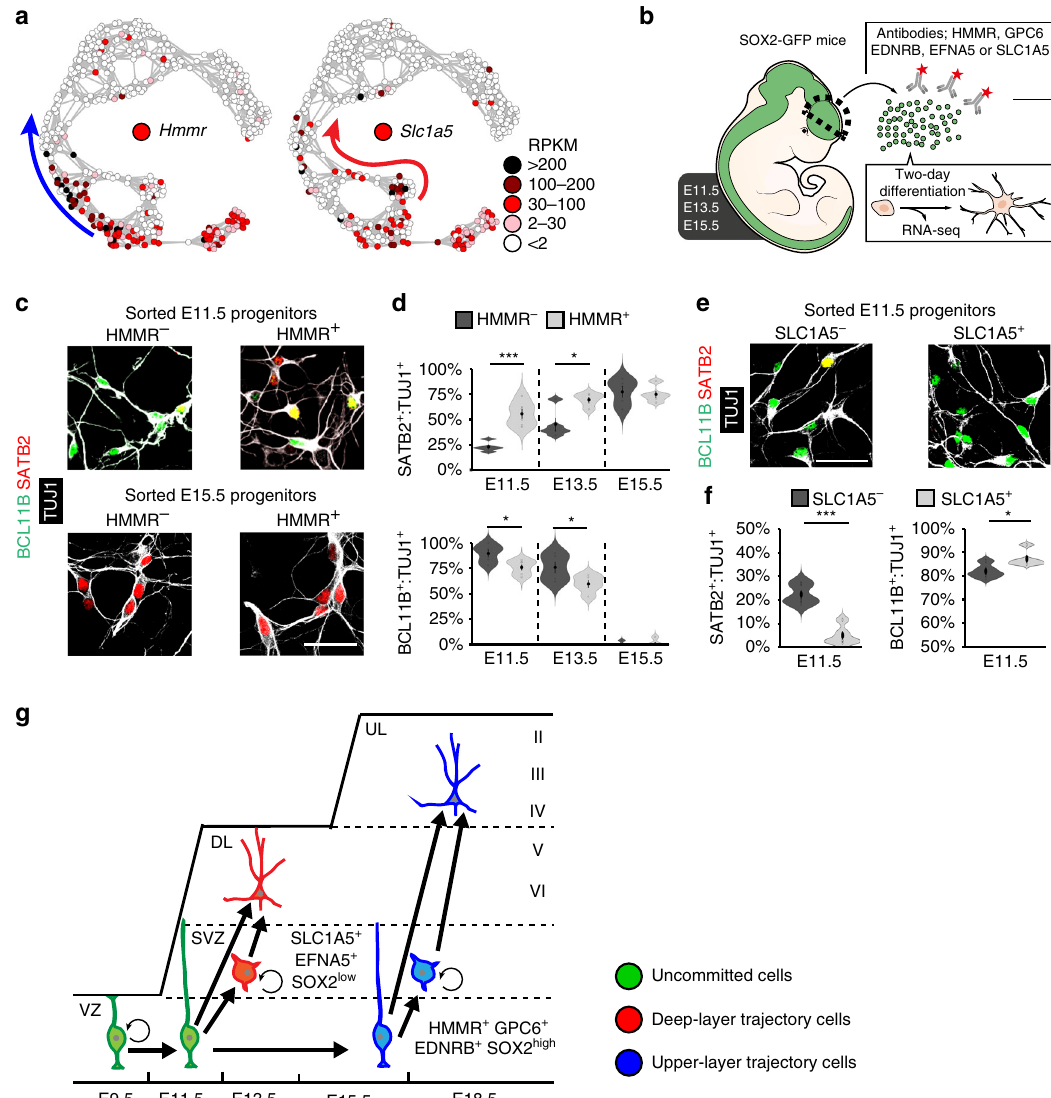
Fig. 4 Uncommitted cortical progenitors display multipotent differentiation potential. a t SNE-NN maps coloured by Hmmr or Slc1a5 expression levels in cortical cells. b Schematic showing dissection of E11.5, E13.5 and E15.5 Sox2 -GFP cortices, antibody labelling of cell-surface markers enriched in uncommitted progenitors and progenitors committed to upper-layer (HMMR and GPC6, enriched in upper-layer-trajectory gene set 1; EDNRB enriched in upper-layer-trajectory gene set 2), or deep-layer (SLC1A5, enriched in deep-layer-trajectory gene set 1 or EFNA5 enriched in deep-layer-trajectory gene set 2) differentiation trajectories, FACS-based isolation and in vitro differentiation or RNA-seq analysis. c , d Immunohistochemistry ( c ) and quanti fi cation ( d ) of BCL11B and SATB2 expression in TUJ1 + neurons derived from HMMR + and HMMR − progenitors after two days of differentiation. E11.5 ( n = 5 biological independent experiments; p-values SATB2 5.38e-4, BCL11B 0.023), E13.5 ( n = 4 biological independent experiments; P -values SATB2 0.015, BCL11B 0.048) and E15.5 ( n = 5 biological independent experiments). e , f Immunohistochemistry ( e ) and quanti fi cation ( f ) of BCL11B and SATB2 expression in TUJ1 + neurons derived from E11.5 SLC1A5 + and SLC1A5 − progenitors after 2 days of in vitro differentiation ( n = 5 biological independent experiments; P - values SATB2 1.48e-4, BCL11B 0.03). g Schematic of relationships between uncommitted cortical cells (green) and cortical cells committed to deep- (red) or upper-layer (blue) differentiation trajectories, labelled with markers analysed here. vz ventricular zone, svz subventricular zone, DL deep layer (layer V and VI), UL upper layer (layer II to IV). Scale bar in ( c , e ) represents 20 µ m. Violin plots are inset by rings corresponding to the individual data points, a fi lled dot at the group mean and a vertical line showing standard error. Statistics based on two-tailed t tests; * P < 0.05, *** P < 0.001. Source data are provided as a Source Data fi